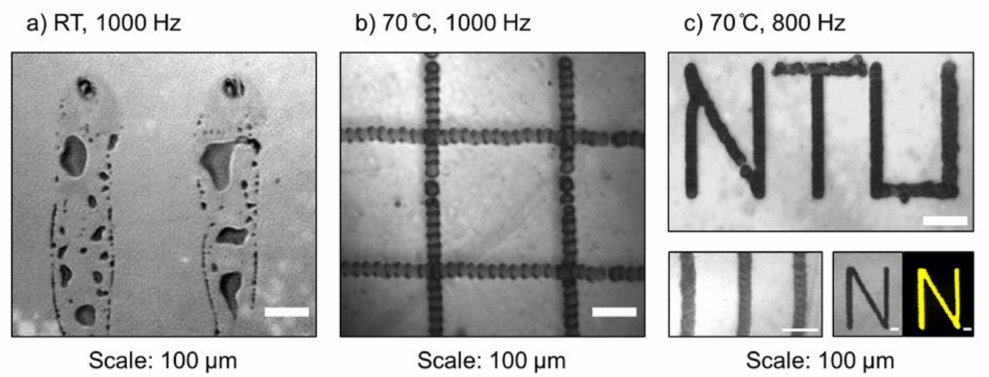
Figure 2. Camera images of printed lipid pattern on TiO 2 substrates. Effect of substrate temperature and inkjet frequency on printing quality: ( a ) DOCP lipid vesicles printed at room temperature, 1000 Hz. Non-uniform patterns with low resolution. ( b ) DOCP lipid vesicles printed at 70 ◦ C, 1000 Hz. Uniform and high-resolution patterns. ( c ) DOCP lipid vesicles printed at 70 ◦ C, 800 Hz. Uniform patterns were formed. The change in frequency had a minor effect. DOCP pattern imaged with a fluorescence microscope (lower right, in